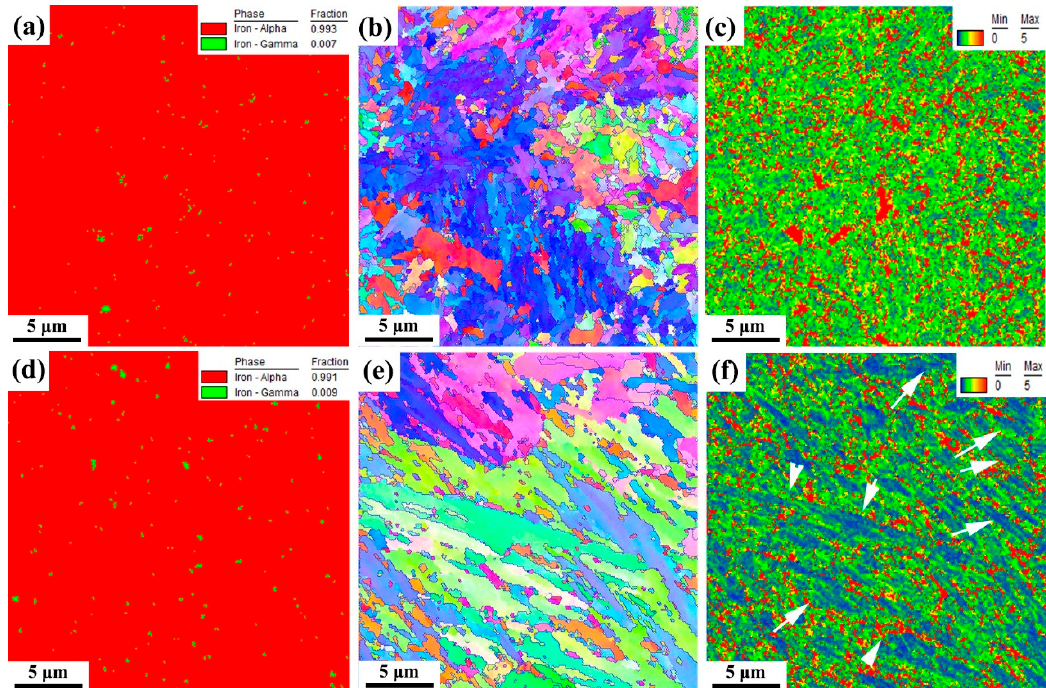
Figure 9. Results that after TF tests. ( a ) to ( c ) are the phase distribution image, inverse pole figure (IPF) image, and Kernel average misorientation (KAM) images of the As ‐ SLMed H13, respectively. ( d ) to ( f ) are the SEM image, IPF image, and KAM image of the Forged H13, respectively . (2) The Effect of Block Size.